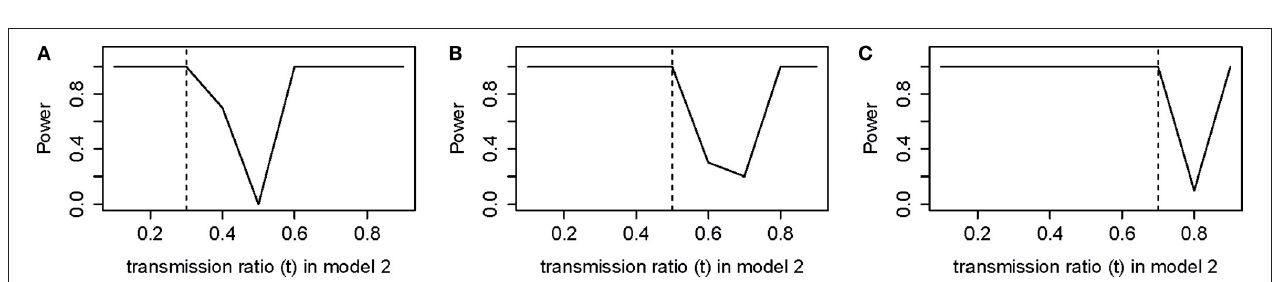
FIGURE 4 | Log ratio of RR in model 2 (Adjusted) for selected t (from 0.1 to 0.9) vs. True t .